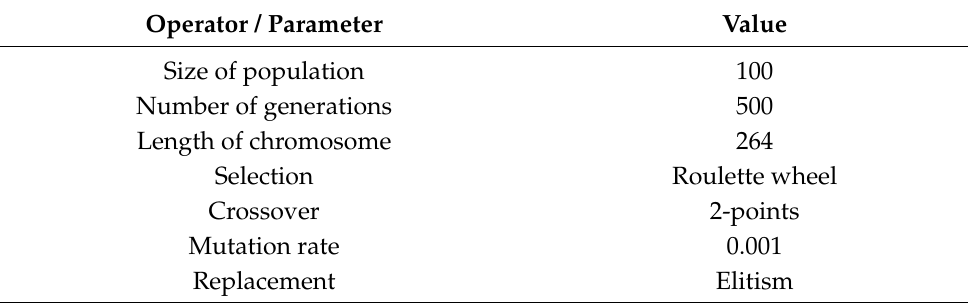
Table 1. Operators and parameters of our genetic